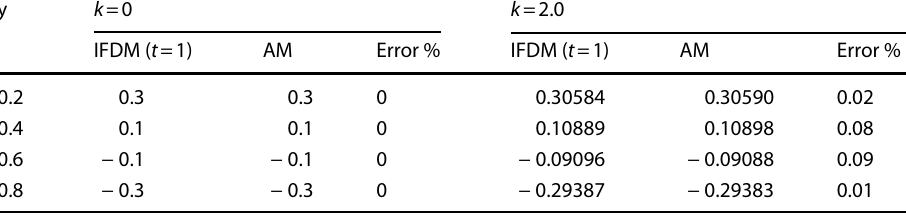
Table 1 Numerical values for velocity obtained using the implicit finite difference at t = 1.0 and velocity obtained analytically when Pr = 0.71, b = 10 , Sc = 0.6, Bi 1 = 1.5, Bi 2 = 15, 𝜆 = 1.5, 𝛼 = 10, N c = 2.0 and N